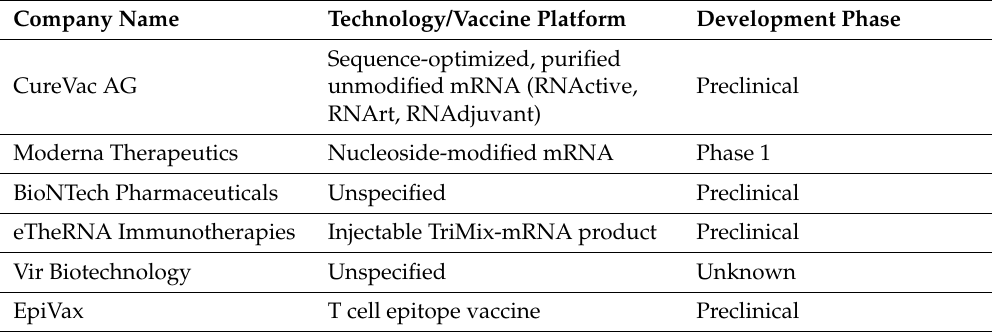
Table 4. Companies involved in RNA-based influenza virus vaccine